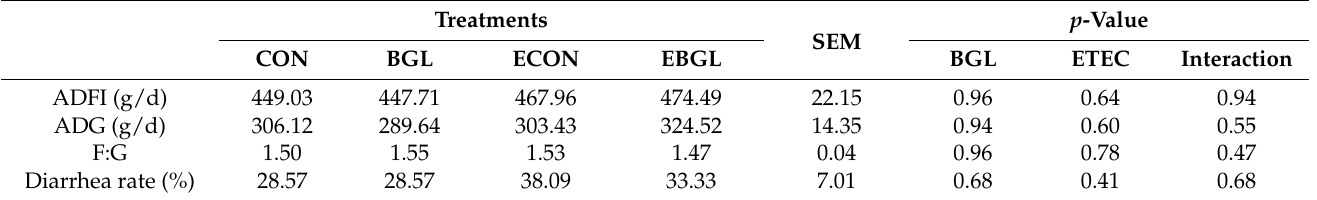
Table 1. Effect of BGL supplementation on ADFI and ADG in weaned pigs during the experiment. Treatments